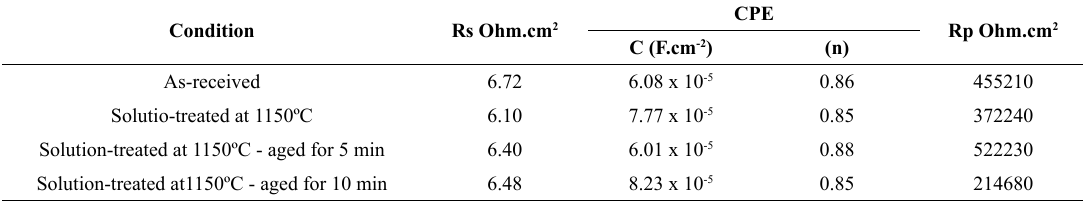
Table 6. Values of resistance and constant phase element obtained for the UNS S32550